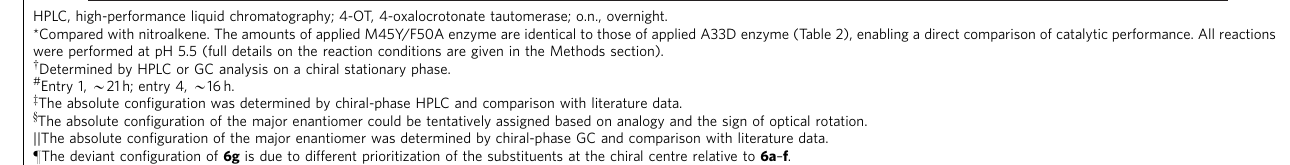
2R3S enantiomer. Mutations at positions His-6, Arg-11, Met-45, Phe-50 and Gly-54 had the most pronounced effect on inversion of enantioselectivity. Three of these positions (His-6, Met-45 and Phe-50) overlap with the positions at which single mutations were positions (H6I, R11I, M45H, F50A and G54E) was purified and